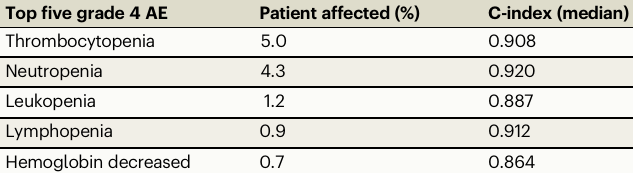
Table 2 | Predictive accuracy for grade 4 life-threatening AEs